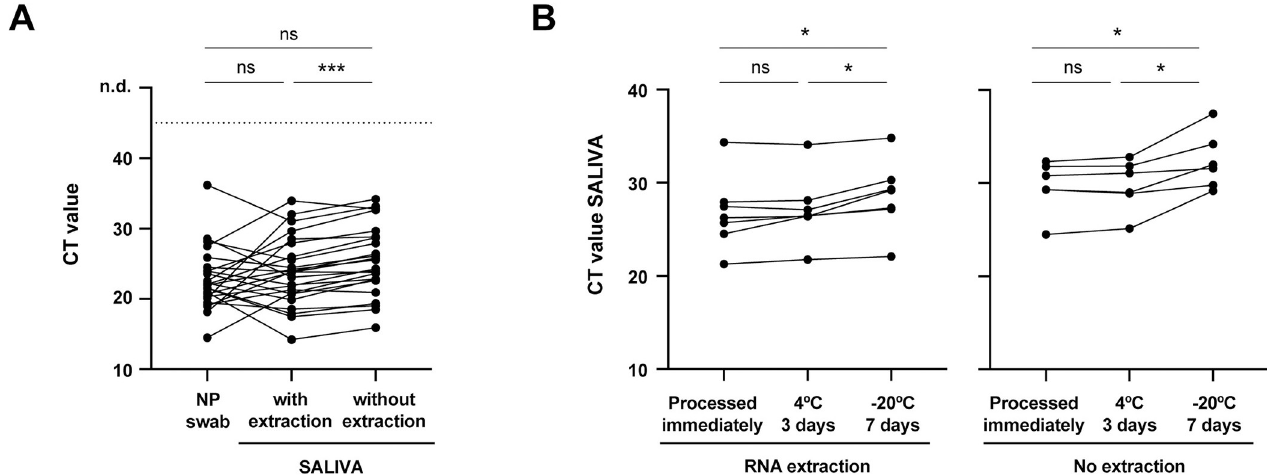
Fig 1. SARS-CoV-2 RNA detection in NP swab and saliva samples from adult patients infected with SARS-CoV-2. (A) Comparison of CT values from paired saliva (with and without RNA extraction) and NP swab specimens (N = 24). (B) Saliva stability at 4˚C and -20˚C: comparison of CT values from paired saliva samples [with RNA extraction (N = 7) and without RNA extraction (N = 6)] processed immediately, after 3 days at 4˚C or 7 days at -20˚C. Each line corresponds to a paired specimen. n.d., not detected. ns, not significant; � p < 0.05, ��� p < 0.001, by Wilcoxon matched-pairs signed-rank test.